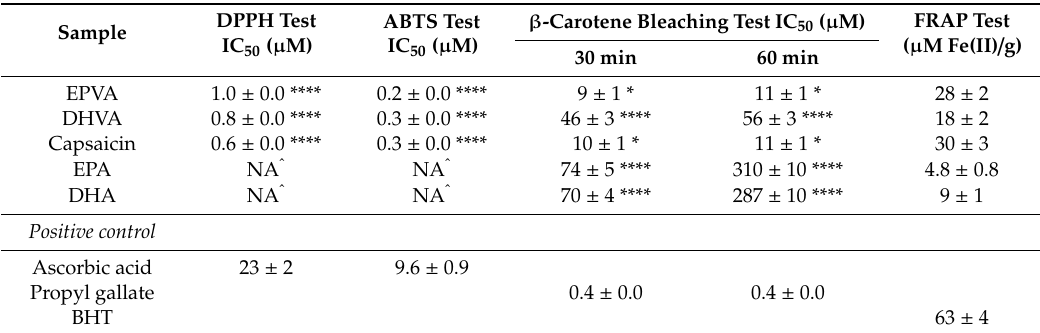
Table 2. Antioxidant activities of capsaicin and its